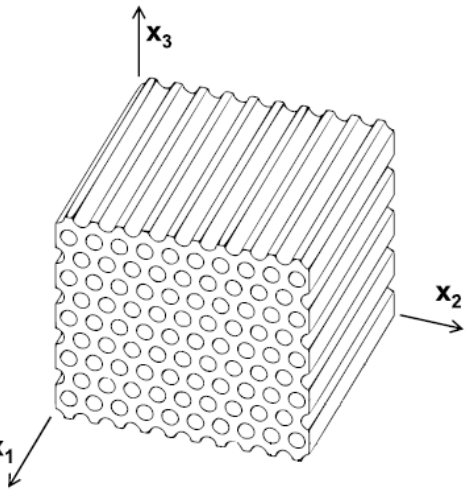
Figure 5. Cross-section of the composite material sample [41].